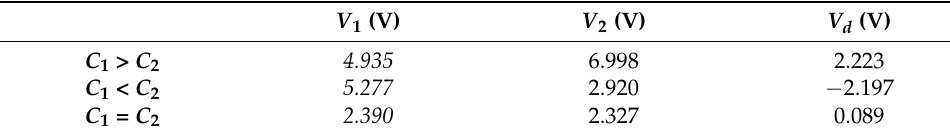
Table 1. Voltage values at the outer of the electronic